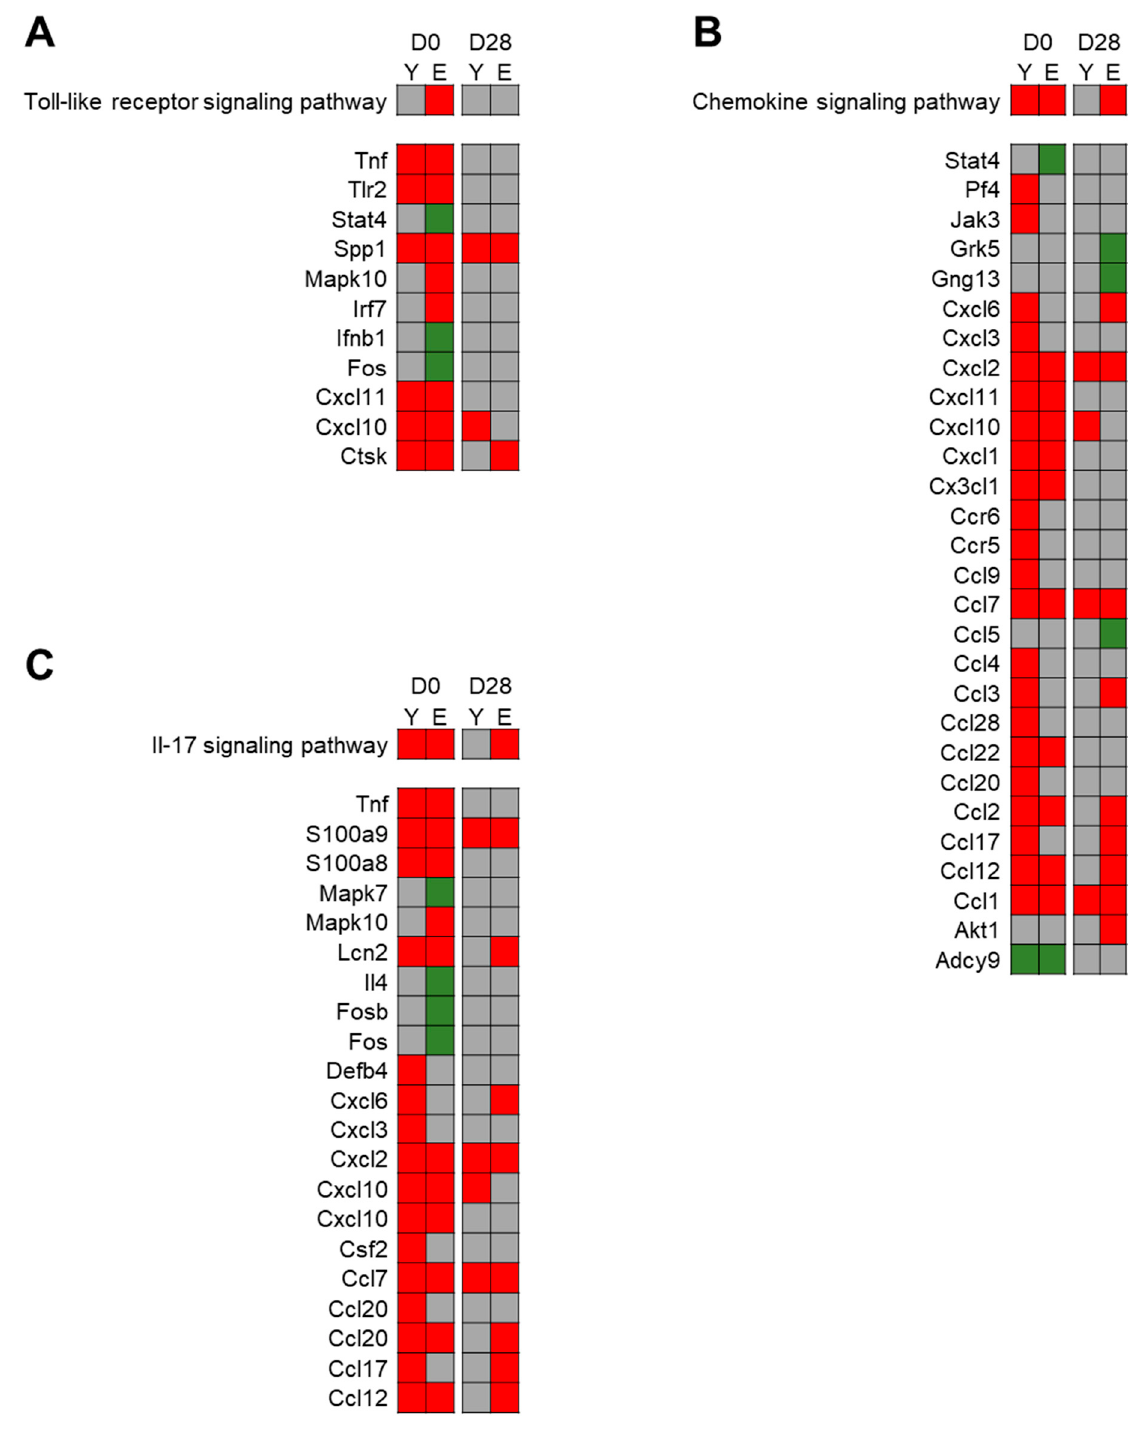
Figure 7. Age effect on exposed rats—Detailed deregulated pathways: Heatmap from FunMappOne tool. Detailed DEGs were presented for “ Toll-like receptor signaling pathway ” ( A ), “ Chemokine signaling pathway ” ( B ) and “ Il-17 signaling pathway ” ( C ). “Columns 1 and 2 represent the data for day 0 (D0) and columns 3 and 4 for day 28 (D28). Columns 1 and 3 represent the data from the young rat group (Y) and columns 2 and 4 from the elderly rat group (E). The color of the boxes represents the expression of the genes involved in these three pathways: green for under-expression, red for over-expression, and grey for no difference.